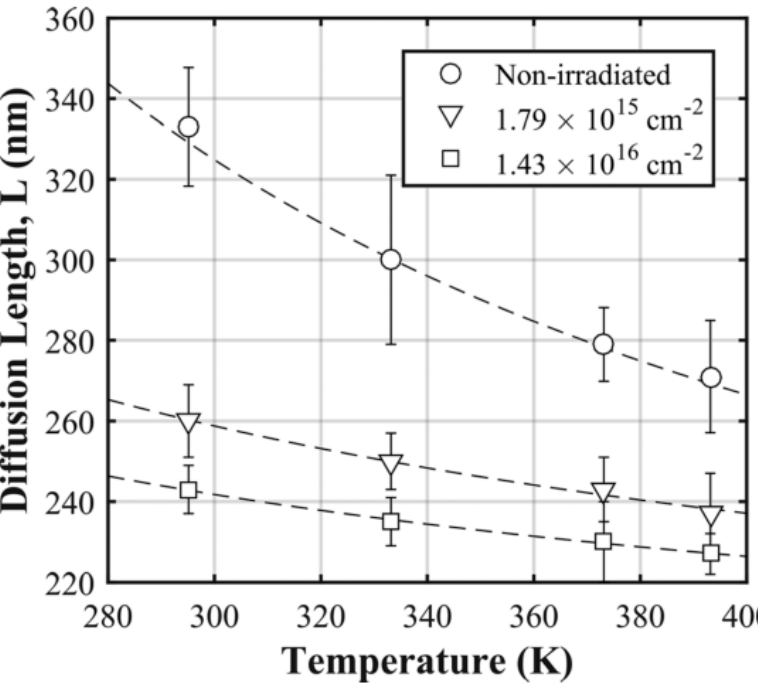
Figure 9. Diffusion length vs. temperature at various fluences (dotted lines indicate fittings). Reprinted/adapted with permission from Ref. [82], 2018, AIP Publishing.